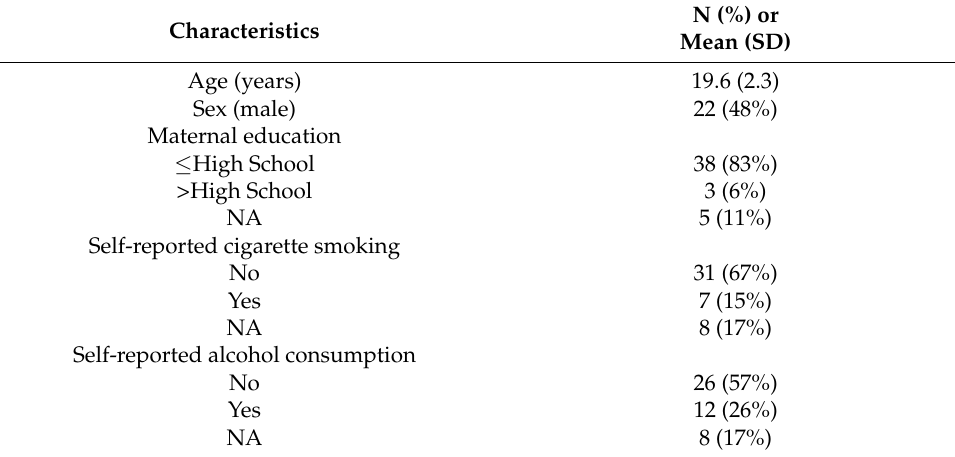
Table 1. Sociodemographic characteristics of selected participants from the Public Health Impact of Metal Exposure (PHIME)